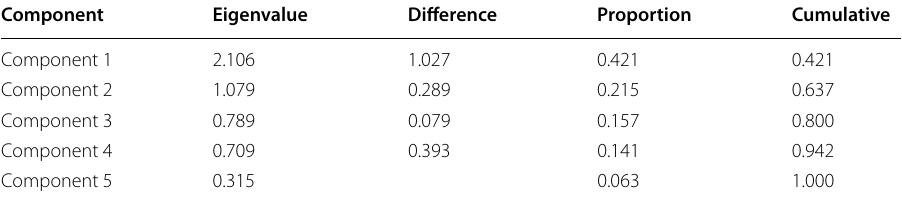
Table 10 Eigenvalues. Source : Authors computations, 2022 Component